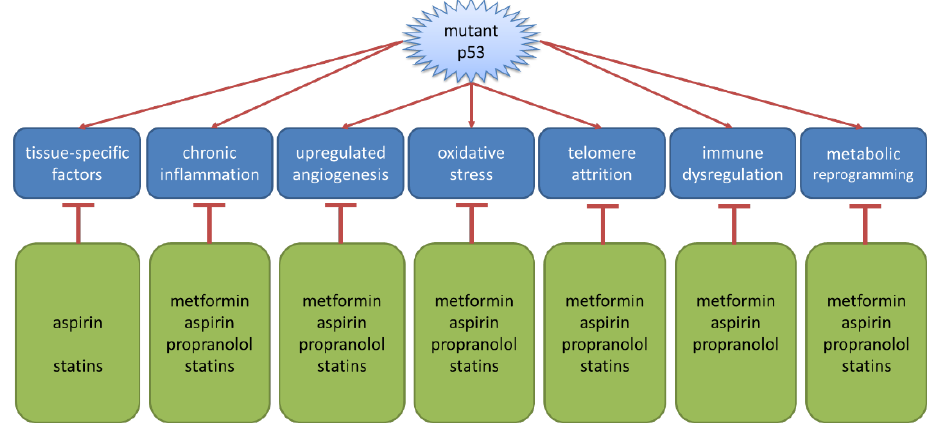
Figure 4. Candidate drugs inhibit key facets of the pre-cancer niche to reduce the risk of malignant transformation.